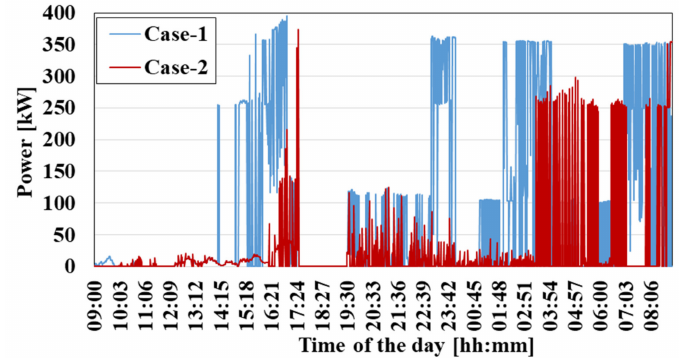
Figure 15. Power consumption of residential community in Case-1 and Case-2.